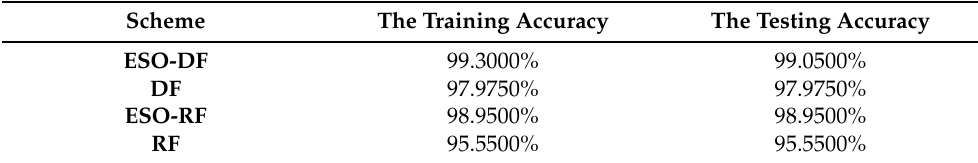
Table 3. Fault diagnosis and fault localization accuracy of different schemes.